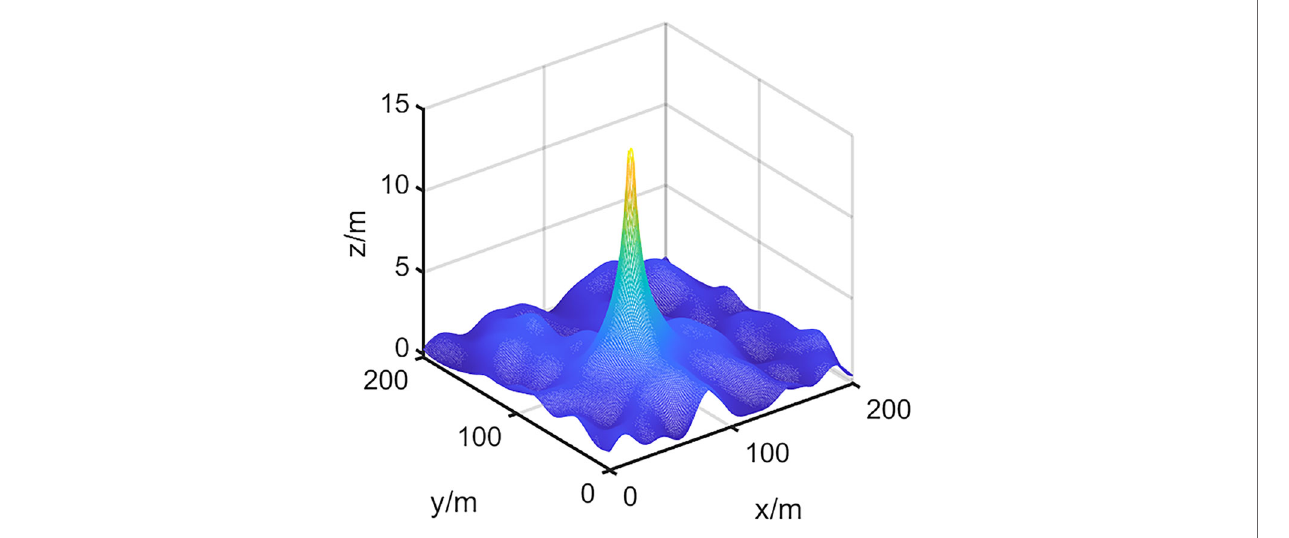
FIGURE 4 | Select a certain area at x=75m, y=75m. Generate freak wave by using energy accumulation